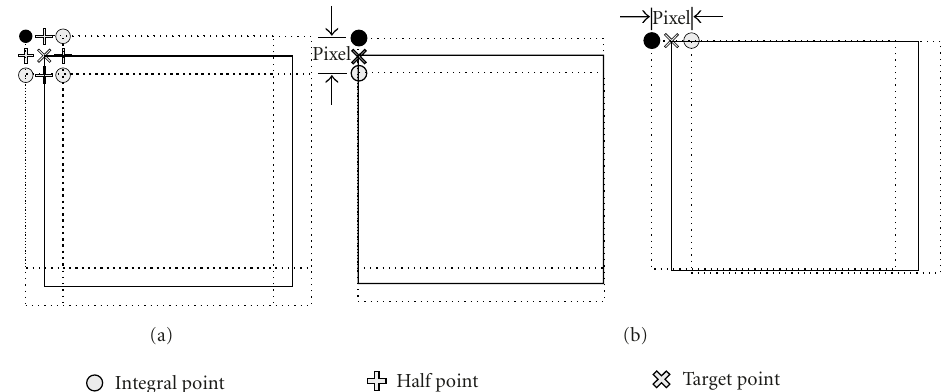
Figure 9: (a) MV x and MV y are all nonintegral (b) MV x orMV y is nonintegral.